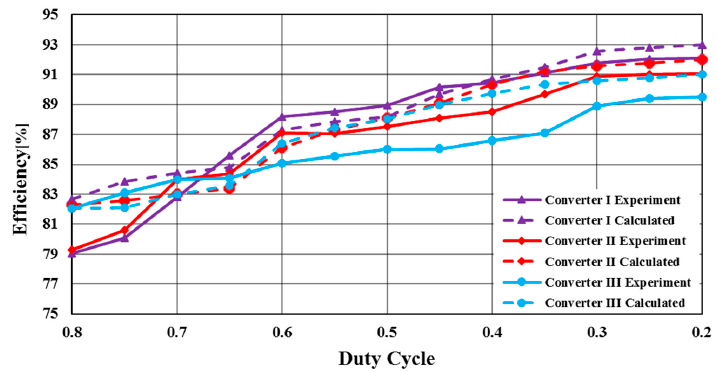
Figure 19. Efficiency comparison between calculated results and experiment results.